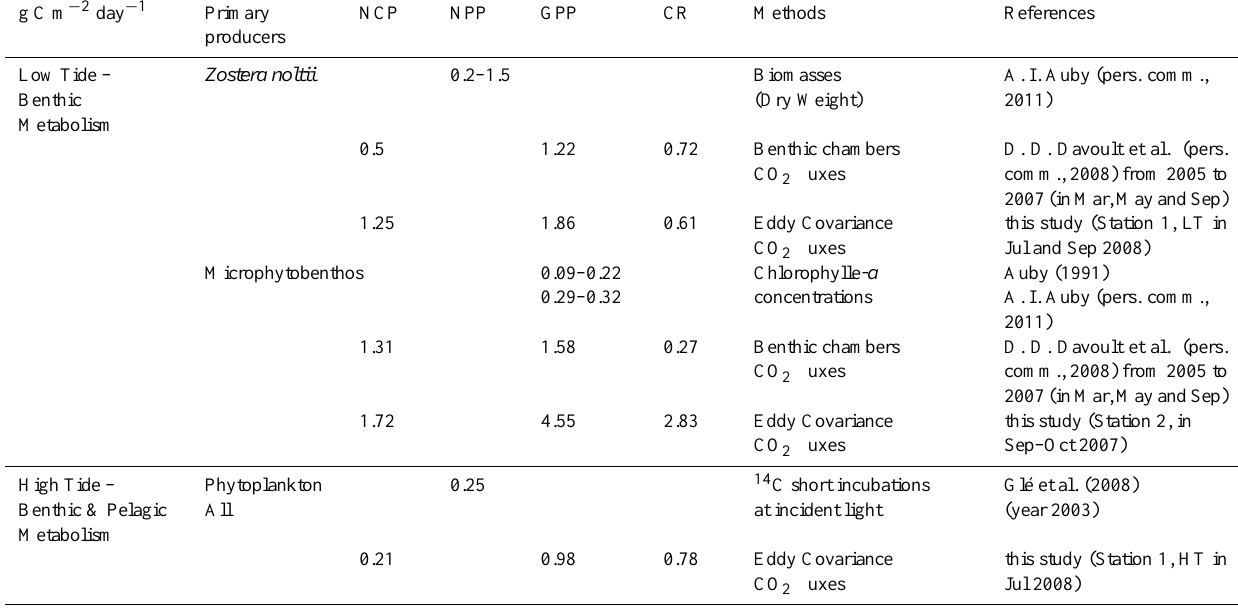
Table 5. Benthic and pelagic metabolic flux estimations in the Arcachon tidal flat (in gCm − 2 day − 1 ) – flux comparisons obtained by Eddy Covariance (this study); short incubations, i.e. benthic chambers (at three different seasons and over muddy and seagrass stations, D. D. Davoult et al., personal communication, 2008), 14 C measurements at incident light (year 2003, Gl´e et al., 2008); and biomass and Chlorophylle- a measurements (Auby, 1991; A. I. Auby, personal communication, 2011). NCP: net community production; NPP: net primary production; GPP: gross primary production and CR: community